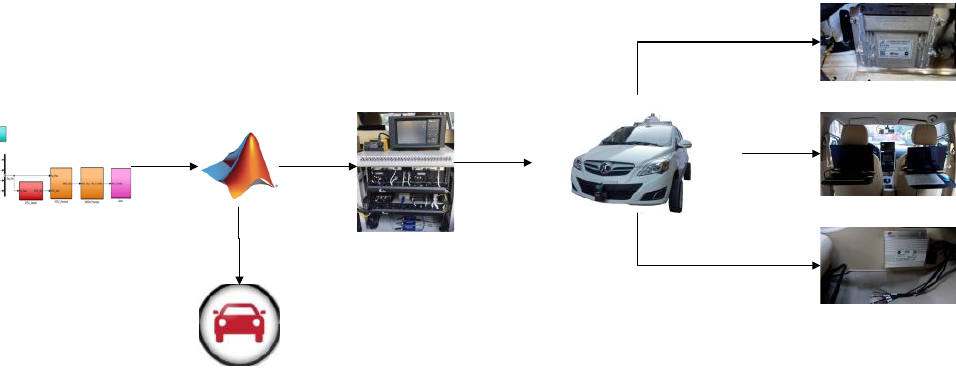
Figure 22. Block diagram of experimental setup.